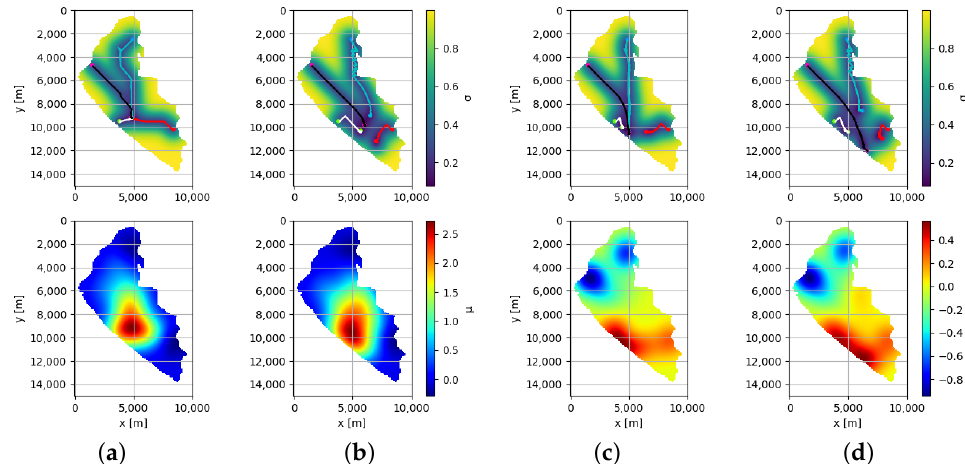
Figure 6. Representation of movements of the ASVs and uncertainty in the exploration of the lake surface (top) and mean of the surrogate model (bottom) in two different ground truths.